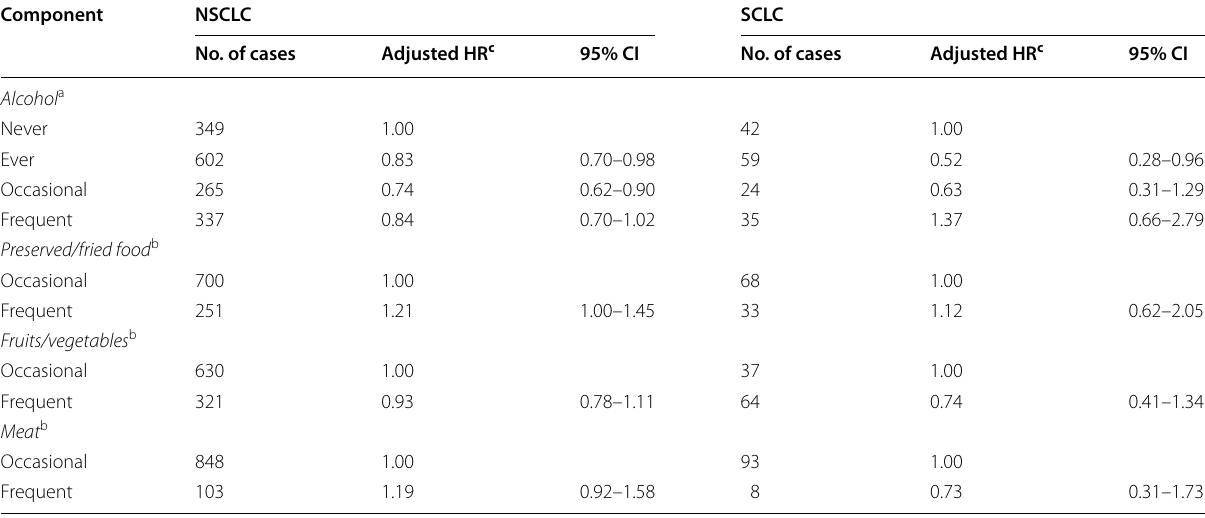
Table 3 Adjusted risk of lung cancer death in relation to levels of alcohol consumption and dietary habits in Chinese men according to histologic